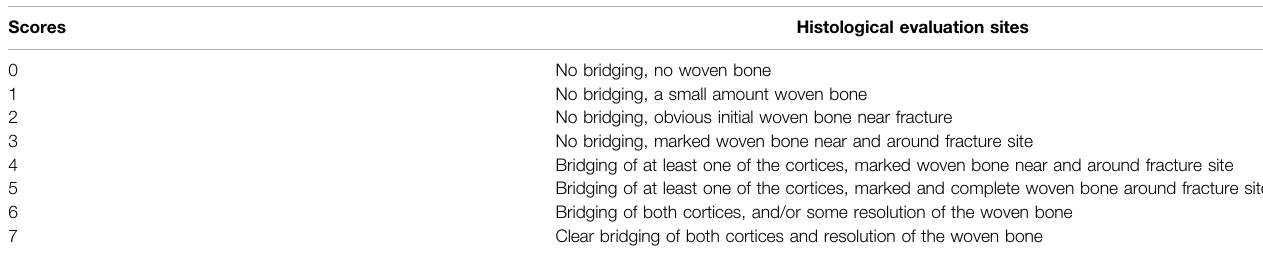
TABLE 2 | Histological evaluation scoring scale of fracture healing.